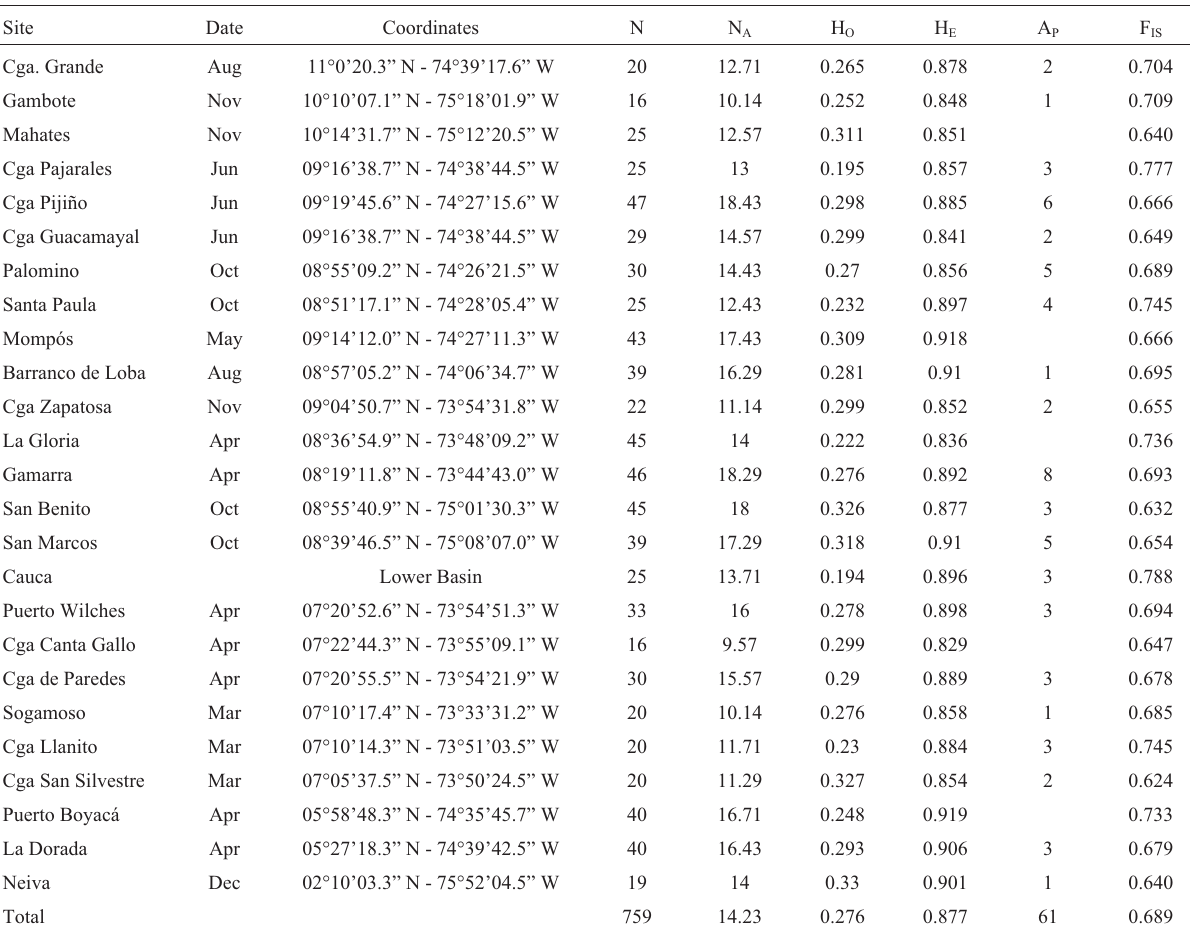
Table 1 - Genetic diversity of P. magdalenae collected at 25 sites on the Magdalena River basin and main tributaries. Sample size (N) per site, observed (H o ) and expected (H E ) heterozygosity, average number of allele (N A ), inbreeding coefficient (F IS ) and private alleles (A P ). Significant value p <